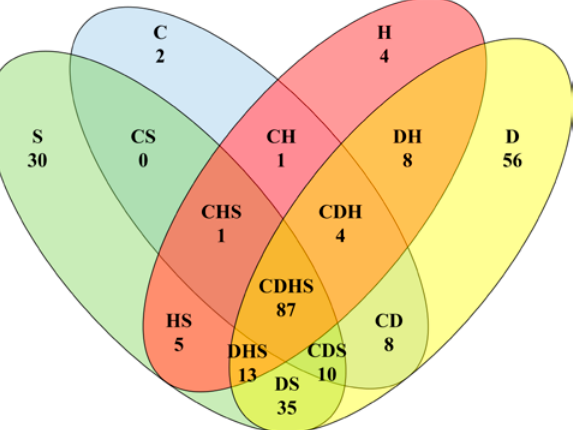
Fig. 6. Venn diagram of expressed (MRpM > 1) LTR-REs in the four stresses used in these experiments (D = drought; H = heat; C = cold; S = salt). Results of short and prolonged treatments were cumulated for each stress.